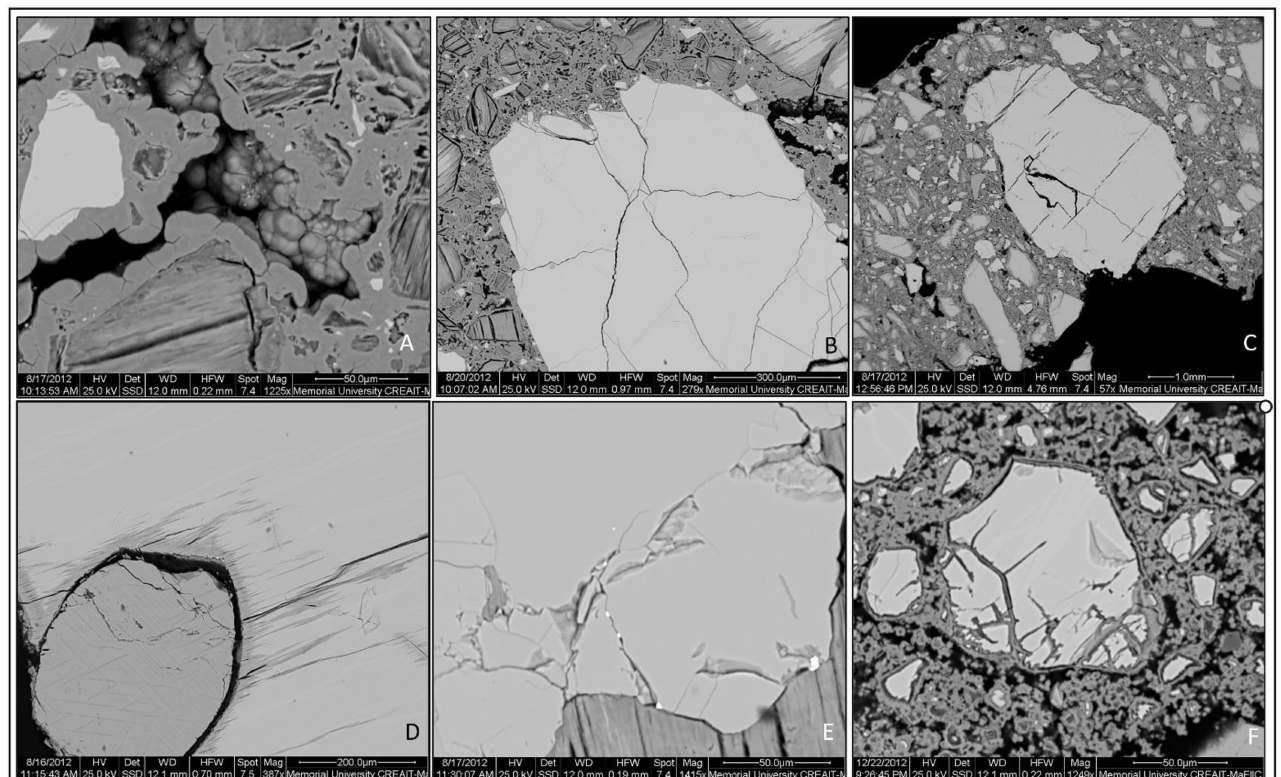
Figure 17. BSE images of coarse rejects polished grain mounts, and one pulp sample from the Reid Brook Deposit, Voisey’s Bay: ( A ) Pn grain (white to left) within botryoidal iron oxide in sample VX60379, ( B ) large, cracked, but unaltered, Pn grain (white) in sample VX60381, ( C ) large, cracked, but unaltered, chalcopyrite (Ccp) grain (grey) in sample VX65905, ( D ) Ag-telluride inclusions (white) along oxidized Po grain margin, magnetite to left in sample VX66130, ( E ) Pd-Bi inclusions (white) along fractures in cracked Pn and along margin with oxidized Po in sample VX65900, ( F ) cracked Po with exsolved troilite and oxidation along fractures in pulp sample